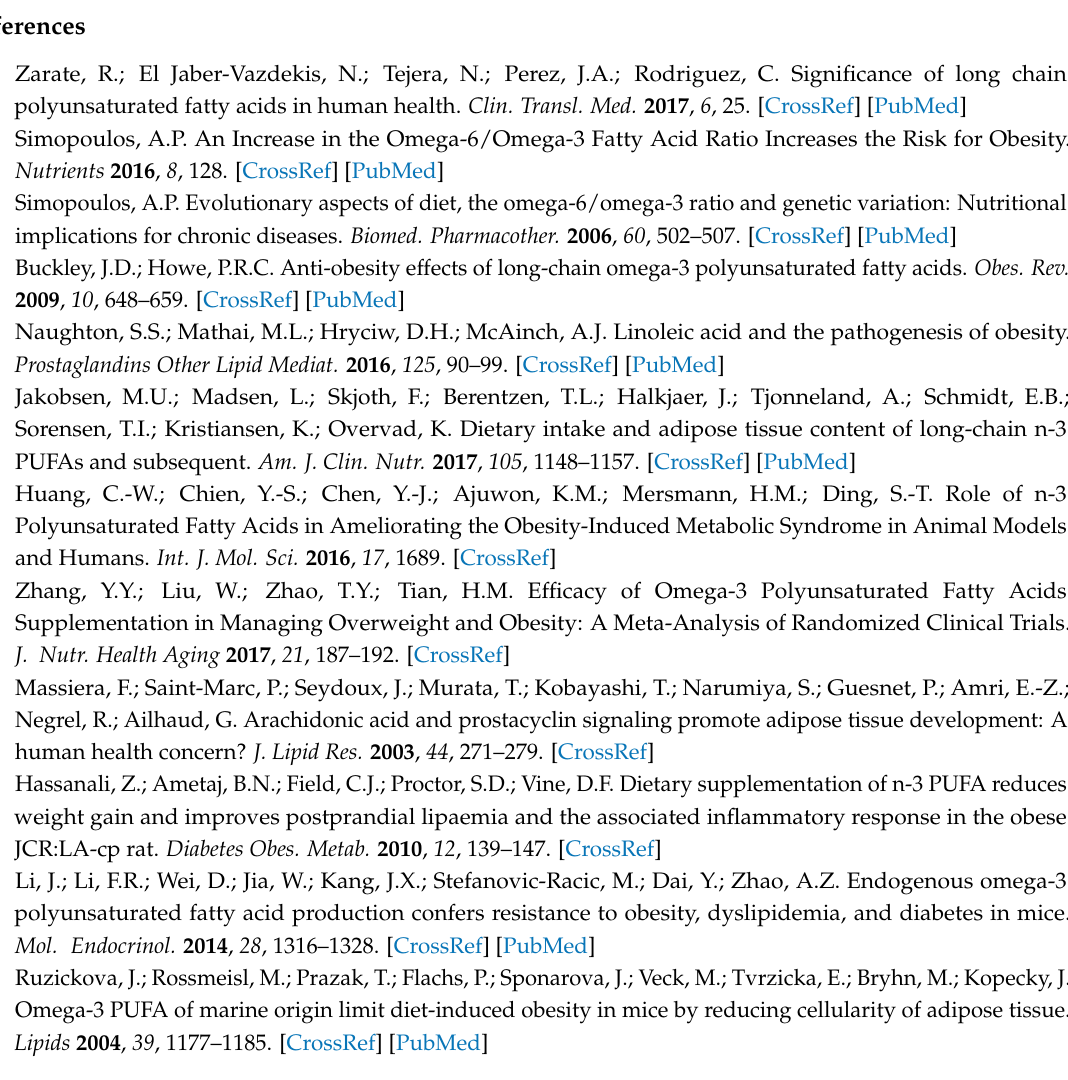
Table S1: Description of the polymorphisms in the NFKB1 gene, Table S2: NFKB1 genotype frequency by racial/ethnic